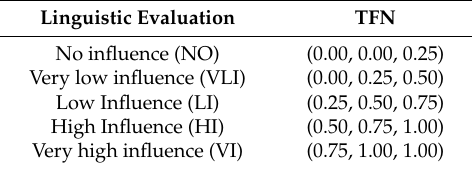
Table 6. Linguistic scale and corresponding triangular fuzzy numbers